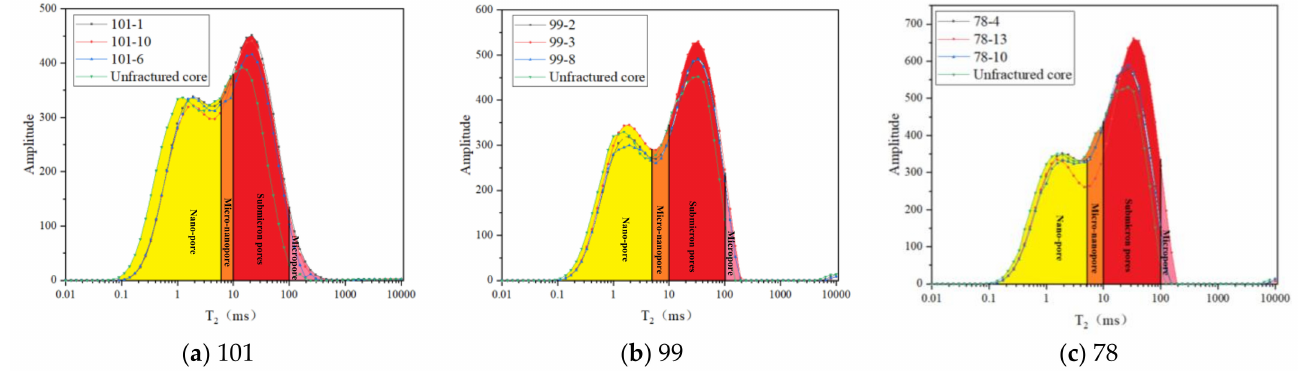
Figure 6. NMR experiment results from the core